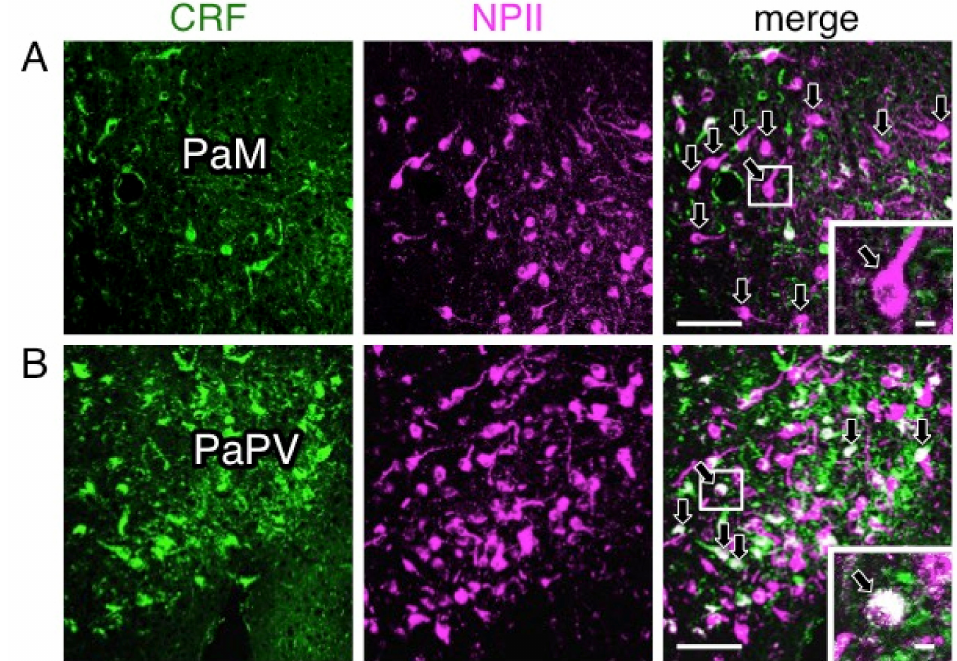
Figure 8. Double-label immunofluorescence for corticotrophin-releasing factor (CRF) and vasopressin- associated neurophysin (NPII) in the paraventricular nucleus (PVN) of the macaque hypothalamus; PaM, magnocellular part of the PVN ( A ); PaPV, parvocellular part of the PVN, ventral division ( B ). Immunoreactivity against CRF (green) and NPII (magenta) is merged in each right-hand panel (overlap; white). The outlined areas in merged images are enlarged. Arrows in ( A ; merged) indicate perikarya single-immunopositive for NPII in the PaM. Arrows in ( B ; merged) indicate doubly immunopositive for CRF and NPII in the PaPV. Scale bars, 100 µ m, and 10 µ m in enlarged